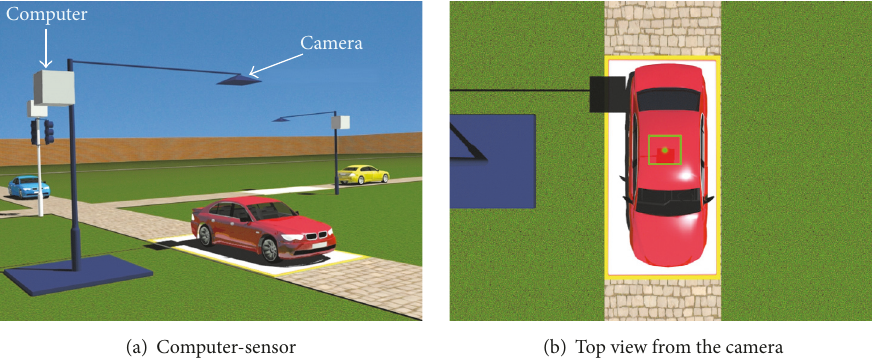
Figure 5: The computer-sensor shown in (a) is composed of a computer and a sensor which could be a simple camera. The example illustrates possible implementation of the sensor. However, the sensor may be an inductive loop, radar, or infrared sensor. In (b), the image obtained by computer-sensor is shown, in which only a car is recognized in the sensing